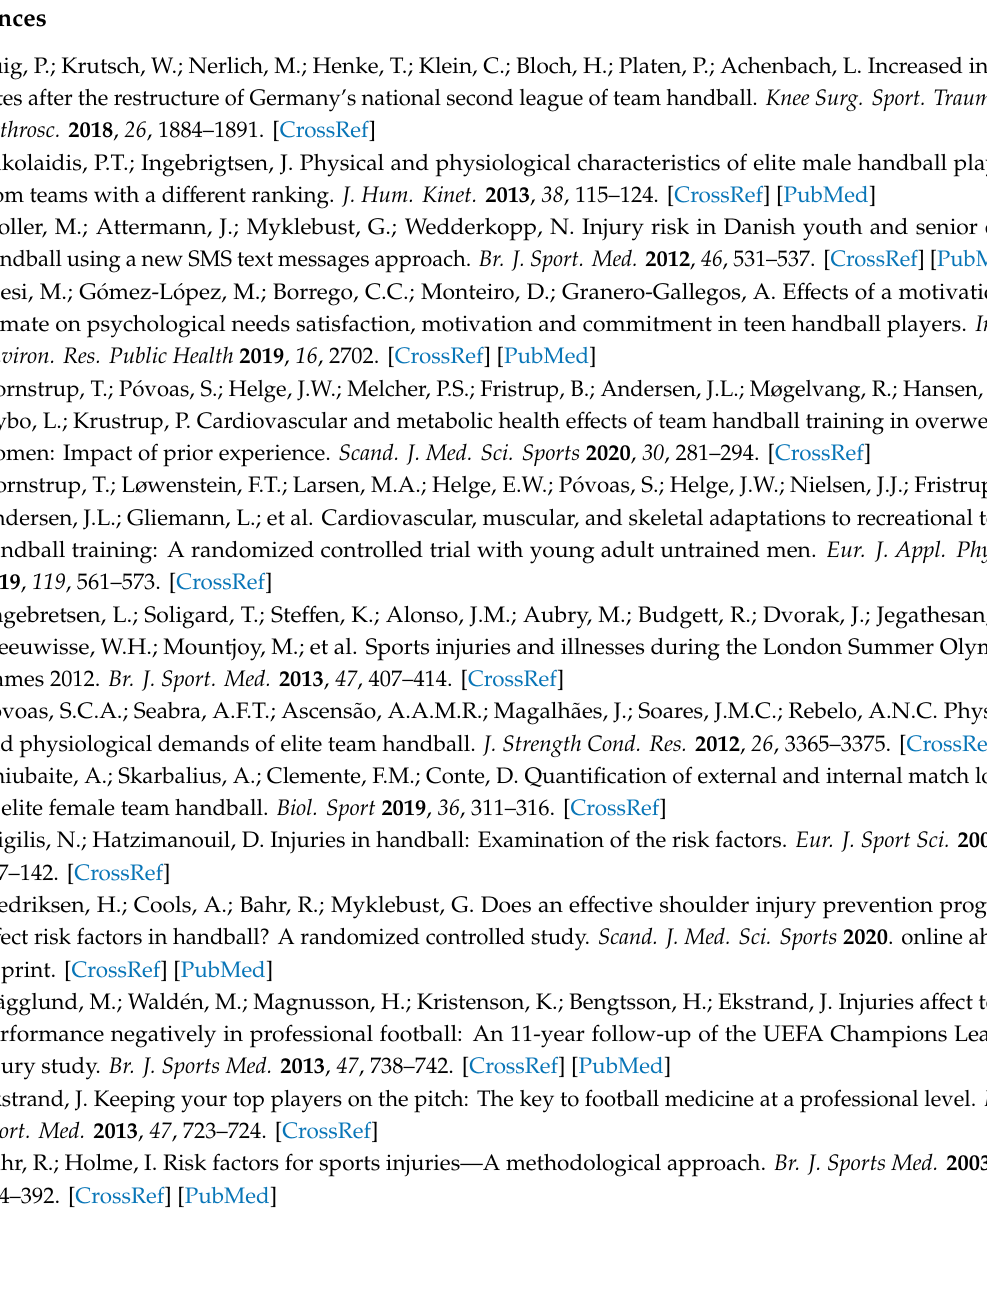
Table S1: Methodologic quality of the included studies for handball